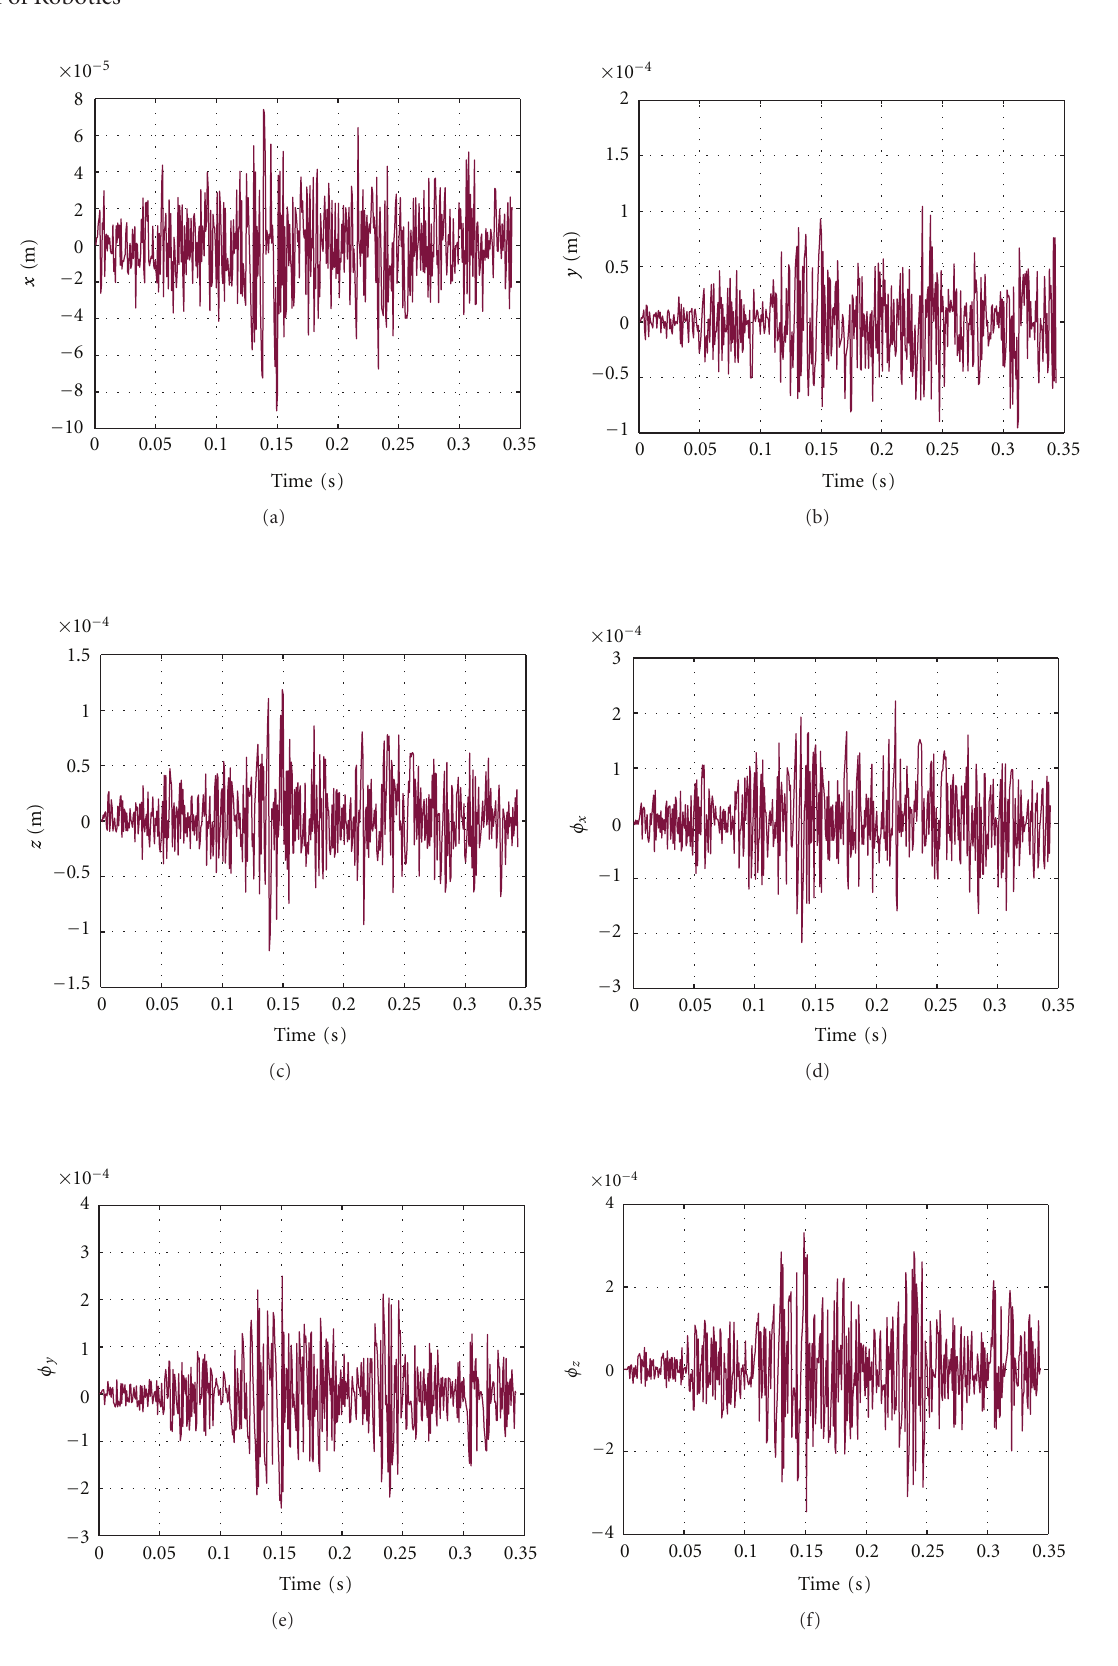
Figure 8: Displacement responses of the moving platform.(a) x direction, (b) y direction, (c) z direction, (d) φ x direction, (e) φ y direction, and (f) φ z